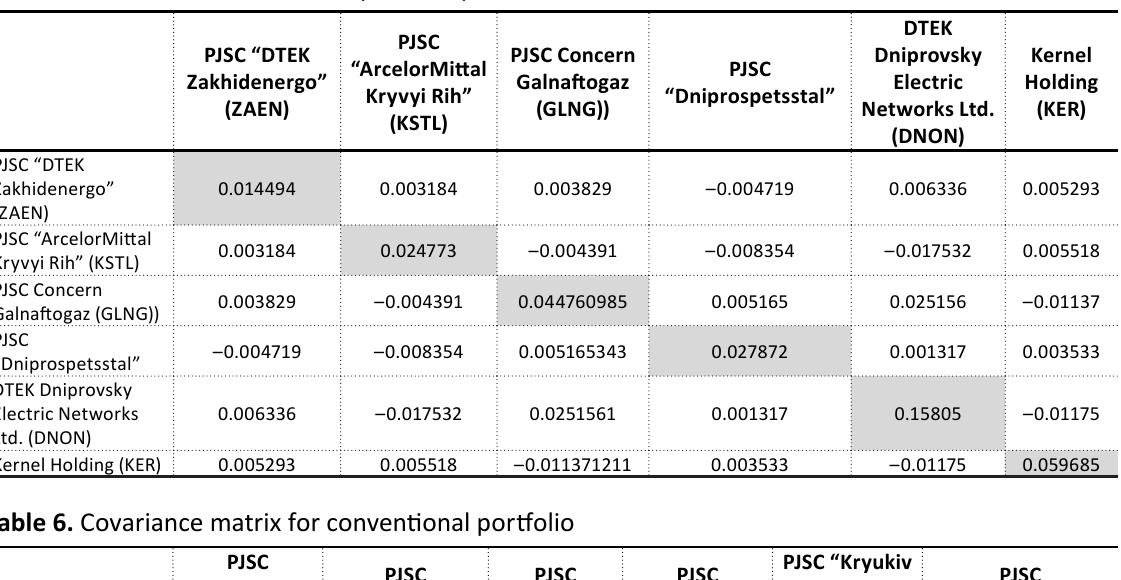
Table 5. Covariance matrix for responsible portfolio